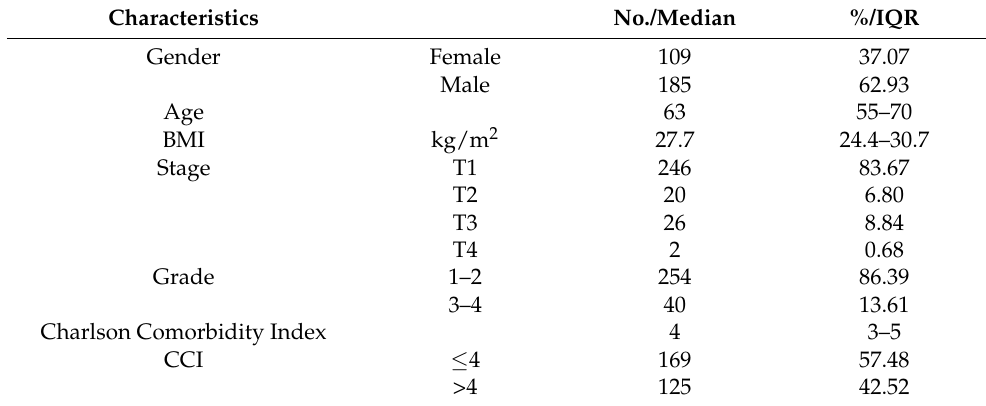
Table 1. General characteristics of the studied cohort of patients with clear cell renal cell carcinoma (ccRCC).